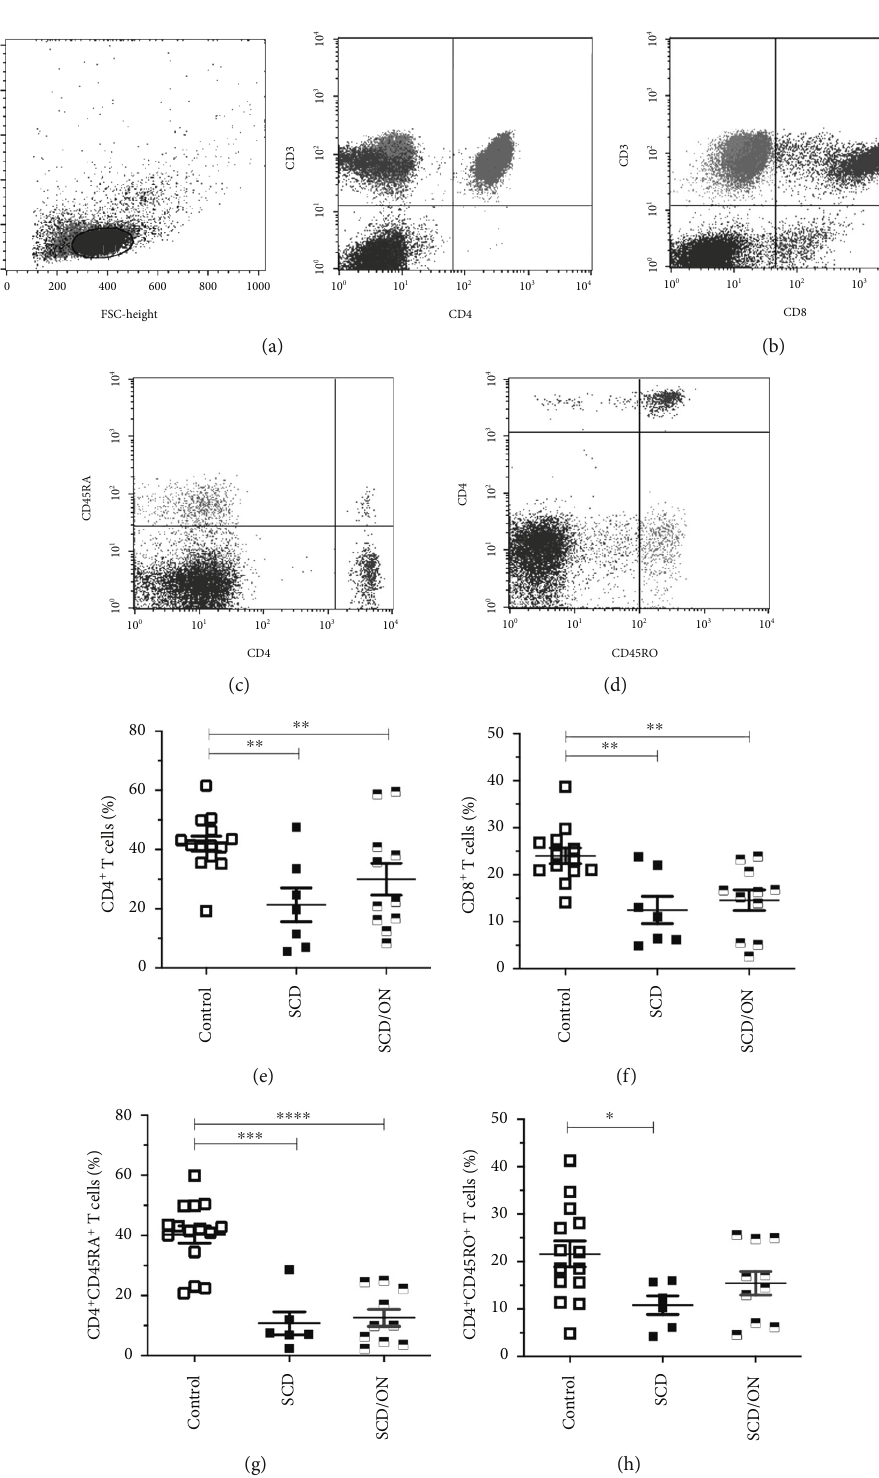
Figure 1: Relative frequency of major T cell populations in peripheral blood mononuclear cells from healthy donors (control), steady-state SCD, and SCD with osteonecrosis (SCD/ON) patients. Representative dot plots illustrate the strategy of gating for major T cell subsets de fi ned by CD3 + CD4 + (a), CD3 + CD8 + (b), CD4 + /45RA + (c), and TCD4 + /45RO + (d) surface expressions in PBMC. All gates were based on isotype- matched control staining. Cumulative data showing the frequencies of total TCD4 + (e), total TCD8 + (f), TCD4 + CD45RA + (g), and TCD4 + CD45RO + (h) subpopulations within live-gated single cells. Each symbol represents an individual subject. Horizontal lines represent mean and standard error. ∗ p < 0 : 05 , ∗∗ p < 0 : 005 , ∗∗∗ p < 0 : 0005 , and ∗∗∗∗ p < 0 : 00005